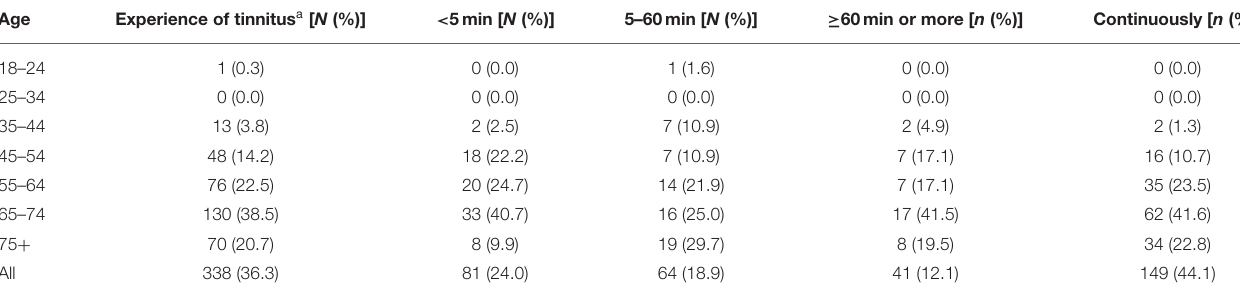
TABLE 1 | Duration of tinnitus experience in the last year stratified per mid-decade age